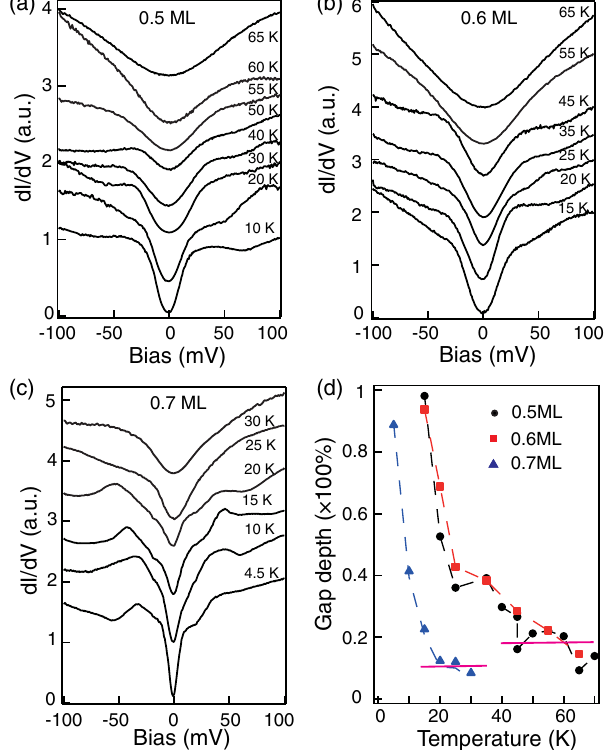
FIG. 4. Temperature dependence of the V-shaped gap. (a) – (c) Temperature dependence of the spatially averaged d I =d V spectra for K coverage of (a) 0.5 ML, (b) 0.6 ML, and (c) 0.7 ML, respectively. The spectra shown here are the average of the d I =d V spectra with large gap depth and visible peaks at the gap edges taken in the LEG-dominated regions of a 30 × 30 nm 2 area. The line-shape variations at different temperatures are caused by the lack of precisely tracking the same location on a clustered surface with strong LDOS inhomogeneity. The curves are offset vertically for clarity. (d) Gap depth (as defined in the main text) as a function of temperature, which decreases gradually with increasing temperature. T L is defined by the temperature at which the gap depth stops decreasing quickly upon